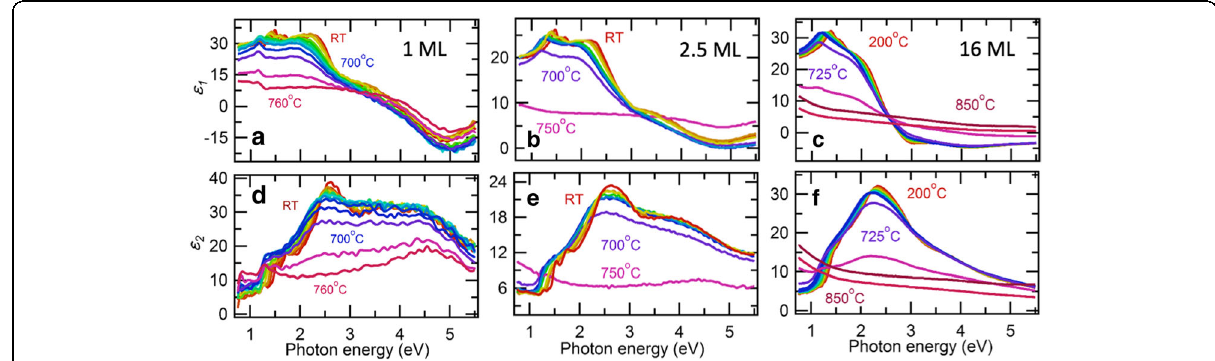
Fig. 3 Temperature dependence of optical spectra of the 1, 2.5, and 16 ML of MoSe 2 films. a – c Real part of the dielectric function ( ε 1 ). d – f Imaginary part of the dielectric function ( ε 2